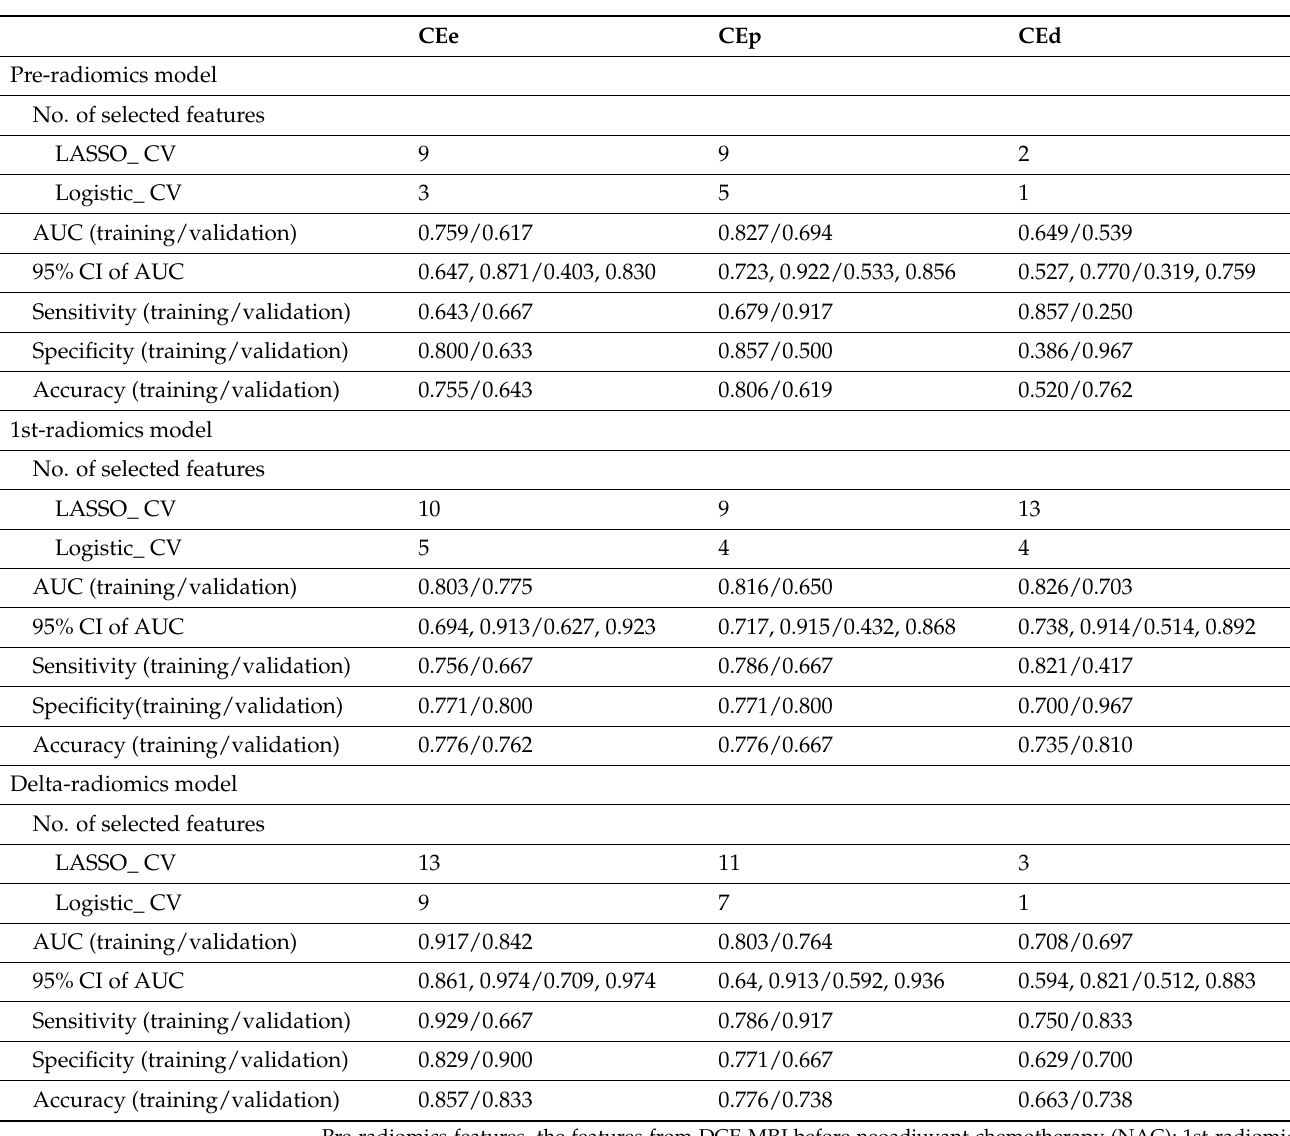
Table 2. Diagnostic performance of separate